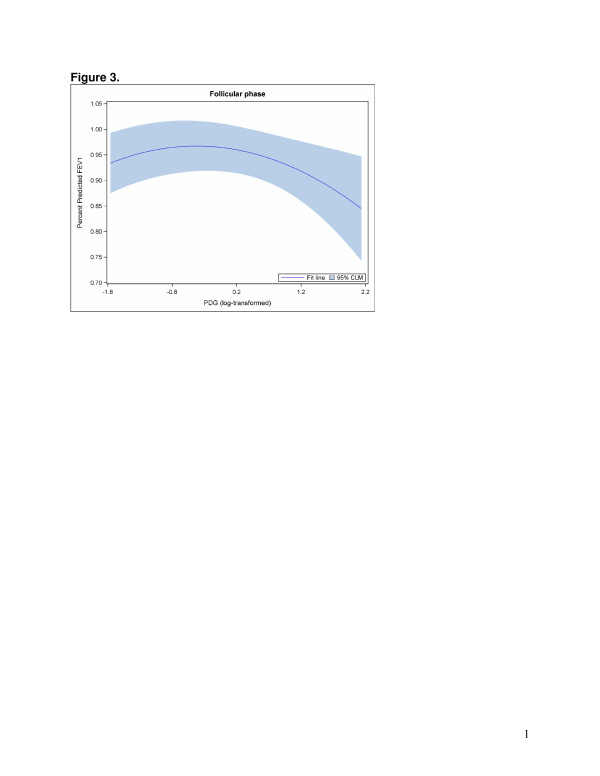
The log of E1C/PDG ratio of hormone levels (x axis) associated with percent predicted FEV1 (y axis) in the follicular phase among women with no prior asthma diagnosis. For purposes of illustrating the relationship between log ratio and FEV1, menstrual segment day is held constant at 7 days prior to ovulation.